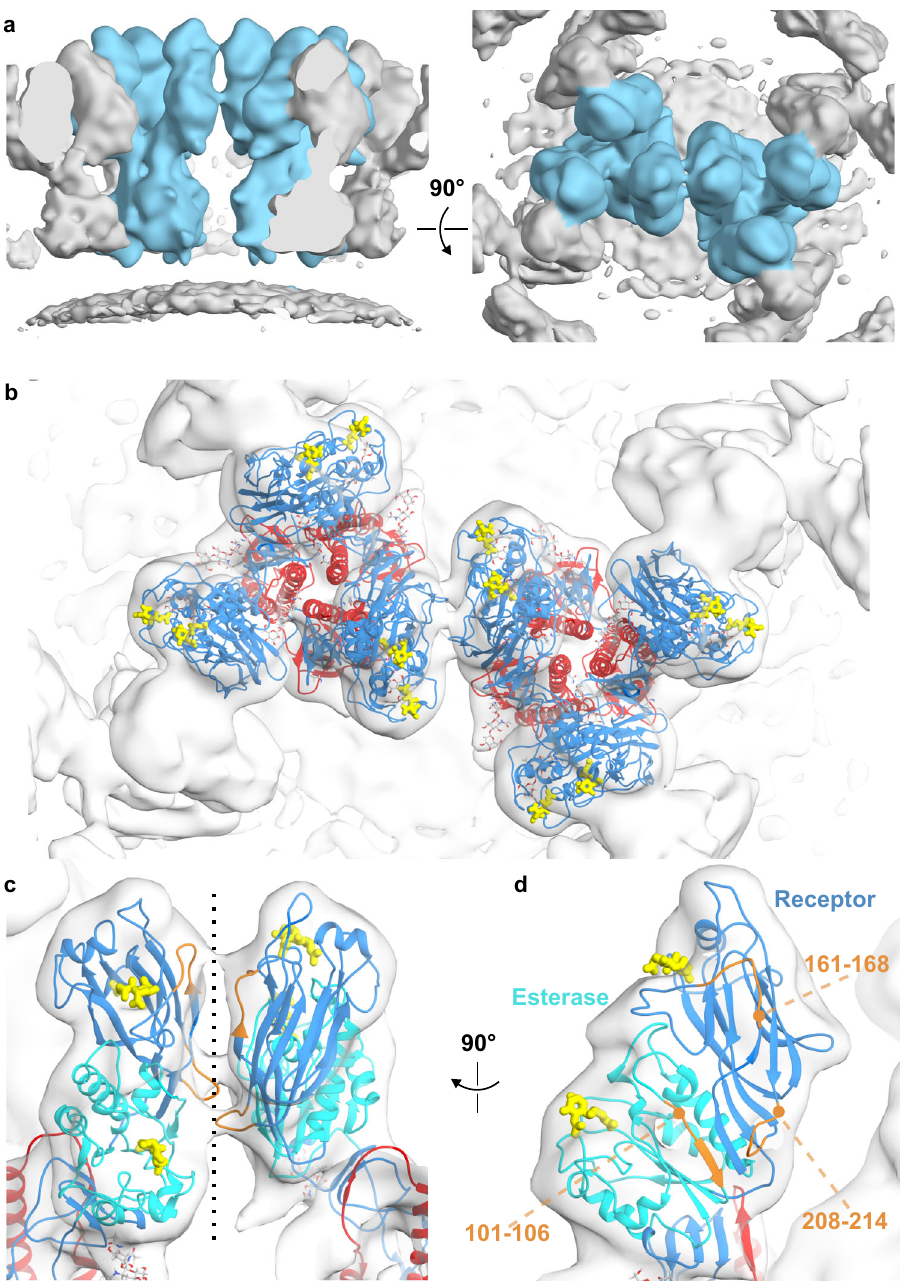
Fig. 3 The HEF1-HEF1 dimer interface is the basis for lattice contacts between HEF trimers. a Side (left) and a top view (right) of a map (10.2 Å resolution, Supplementary Fig. 4) obtained by subtomogram averaging of two interfacing HEF trimers. The central dimer of trimers is colored blue and neighboring trimers and membrane are colored grey. b Two trimers of the fi tted HEF model viewed down the two-fold symmetry axis. c , d The HEF1-HEF1 interface shown in more detail. HEF model shows receptor-binding domain (blue), esterase domain (teal), and HEF2 (red). Three polypeptide segments that are proximal in the dimer interface and may form homotypic contacts (HEF1 R domain loop 161 – 168) and heterotypic contacts (HEF1 R domain loop 208 – 214 and HEF1 E domain 101 – 106) are shown in gold. Potential homotypic contacts (containing atoms within 6 Å) between HEF1 R domain loops 161 – 168 include Leu164 (100% conserved) and Thr167 (99.7% conserved). Heterotypic contacts (containing atoms within 6 Å) occur between HEF1 R domain loop residues Gly211 and Thr212 (both 100% conserved) and HEF1 E residues Tyr101 (100%), Leu102 (100%), and Gln104 (100%), as well as Arg81 (99.4%), part of an additional highly conserved esterase segment. Conservation is based on NCBI non-redundant sequences for in fl uenza C HEF. Panel d shows the view of the interface on one monomer after segmentation. Ligands (yellow) identify the receptor binding and enzyme active sites in b – d receptor binding sites and the esterase active sites are exposed interfaces between trimers in the lattice where binding may within the lattice, with the receptor-binding site being closer to the potentially disrupt lattice contacts 18,19 . The hemagglutinin-esterase (HE) occurs as a dimer on the surface of some beta coronaviruses apex. Antigenic epitopes identi fi ed by antibody escape mutants are and is structurally homologous to the R and E domains of HEF predicted to be mostly exposed in the lattice, but antigenic sites A-3 (25% sequence identity) 20 . We note that the HEF1-HEF1 interface (HEF1 residue 164) and A-4 (HEF1 residue 212) are located at